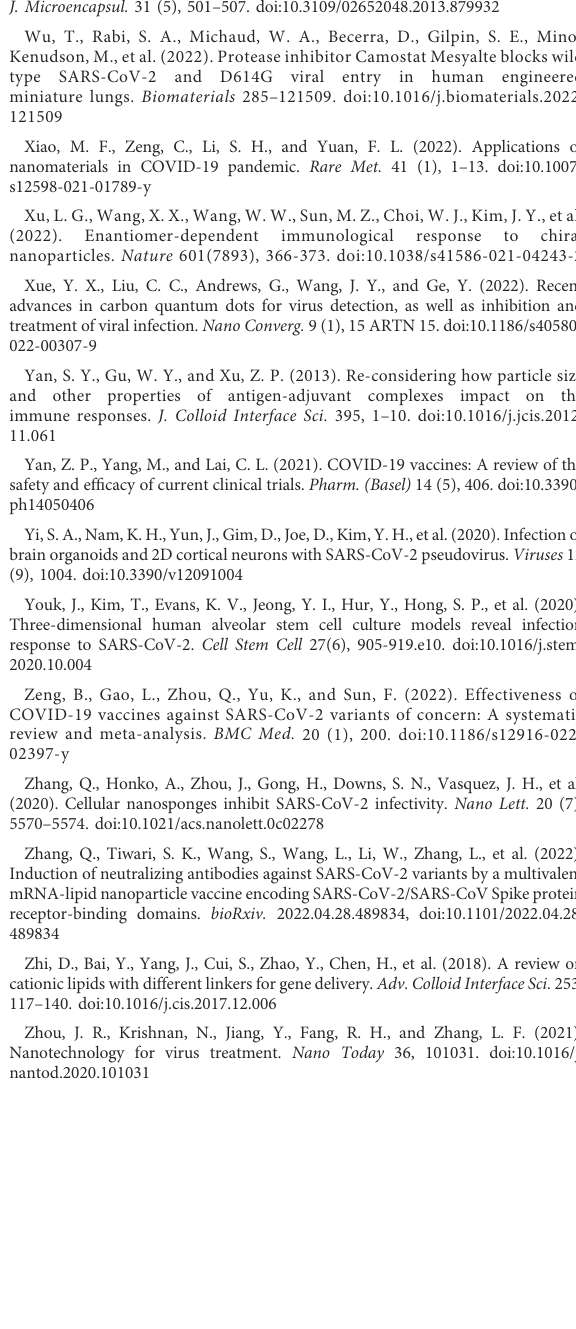
Tabynov, K., Turebekov, N., Babayeva, M., Fomin, G., Yerubayev, T., Yespolov, T.,etal.(2022).AnadjuvantedsubunitSARS-CoV-2spikeproteinvaccineprovides protection against Covid-19 infection and transmission. npj Vaccines 7 (1), 24. doi:10.1038/s41541-022-00450-8 Tanaka, H., Miyama, R., Sakurai, Y., Tamagawa, S., Nakai, Y., Tange, K., et al. (2021). Improvement of mRNA delivery ef fi ciency to a T cell line by modulating PEG-lipid content and phospholipid components of lipid nanoparticles. Pharmaceutics 13 (12), 2097. ARTN 2097.